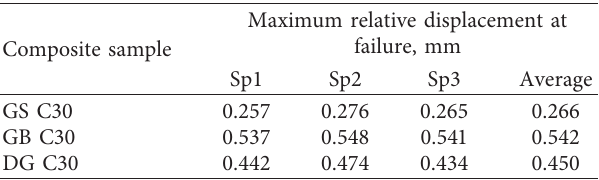
Table 4: The maximum relative bond-slip of the plate-concrete interfaces at failure for composite samples with different cement plates.